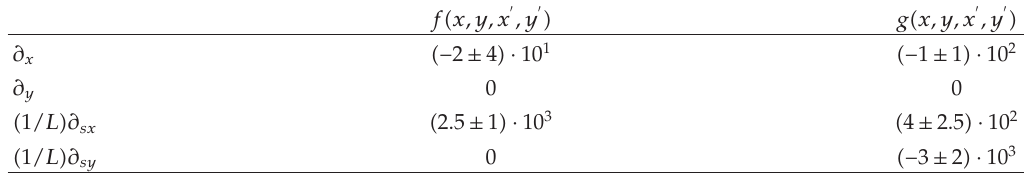
Table 1: Approximate ranges of f (cid:2) x,y,x (cid:3) ,y (cid:3) (cid:3) and g (cid:2) x,y,x (cid:3) ,y (cid:3) (cid:3) derivatives for the standard LHC tune (cid:2) V6.5, collision (cid:4) 12 (cid:5)(cid:3)